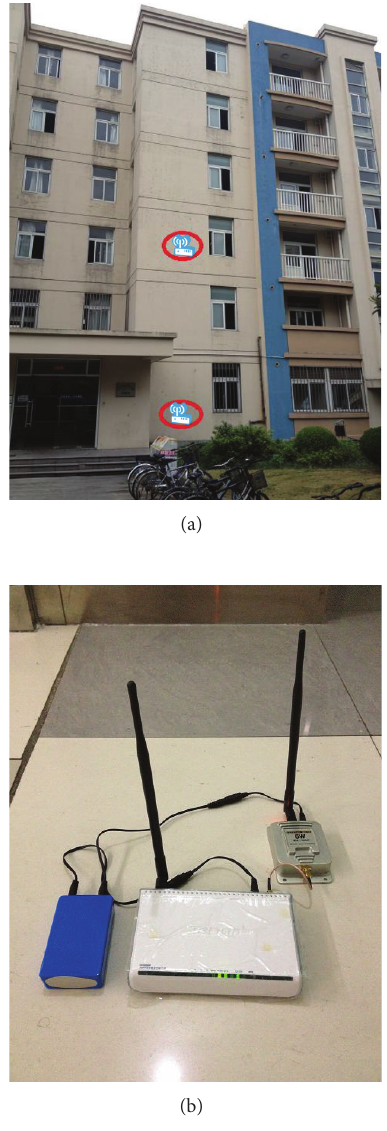
Figure 7: Dormitory building